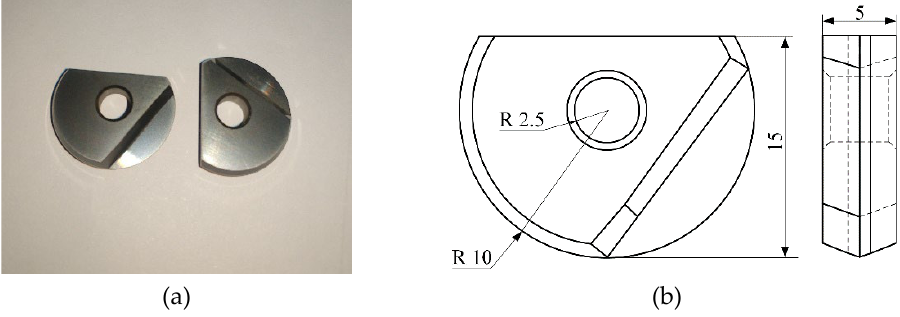
Figure 1. Tool and its size diagram. ( a ) Ball-end milling cutter; ( b ) Tool size diagram.